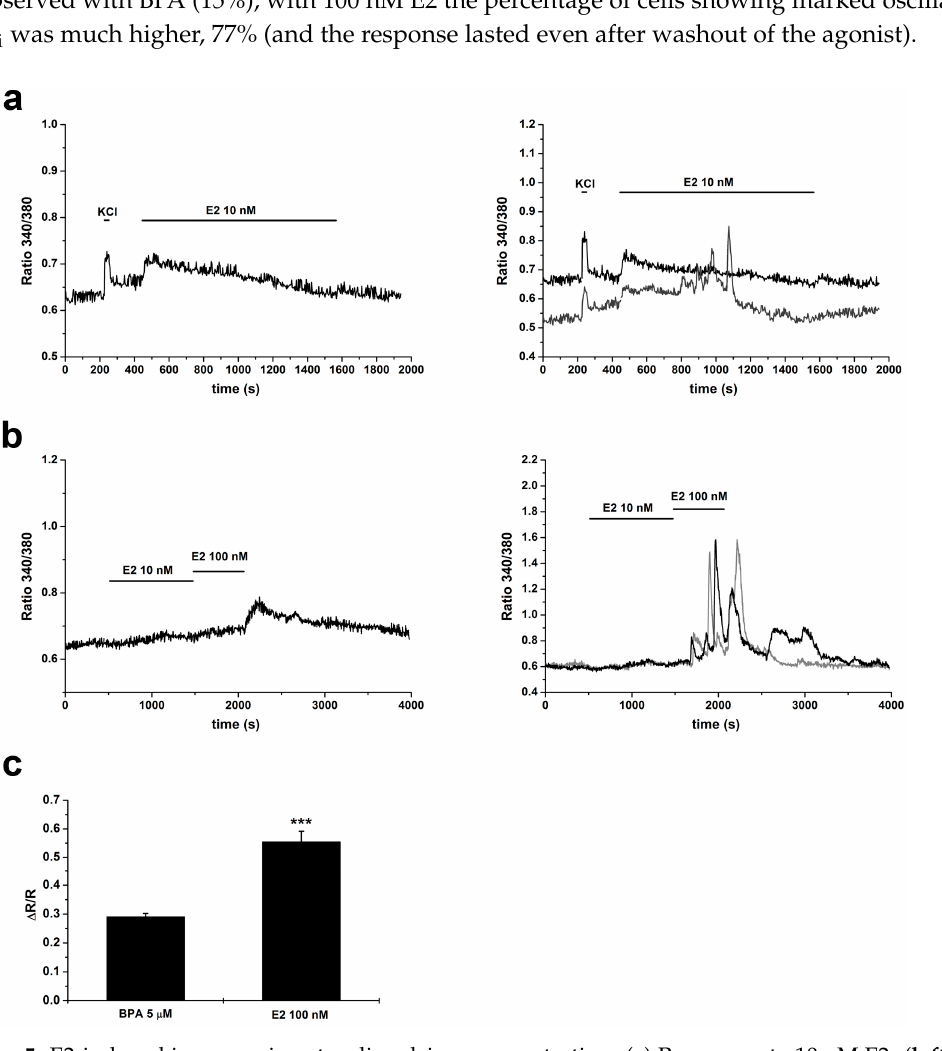
Figure 5. E2 ‐ induced increases in cytosolic calcium concentration. ( a ) Responses to 10 nM E2: ( left ) averaged responses from a single experiment; and (right) examples of responses of individual cells. ( b ) Cells were challenged to incremental doses of E2 (10 and 100 nM): ( Left ) averaged responses from a single experiment; and ( Right ) examples of responses of individual cells. ( c ) Comparison between the amplitudes of responses to 5 μ M BPA (same data as in Figure 3b) and to 100 nM E2 ( n = 181 cells). Mann–Whitney U ‐ test; *** p < 0.001.